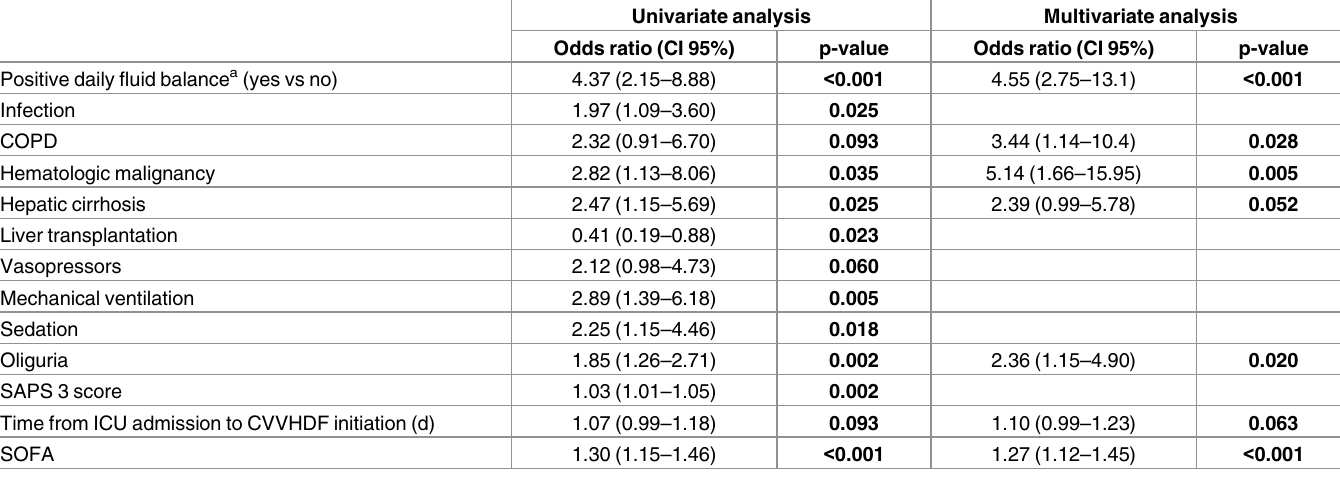
Table 3. Multivariate logistic regression with death at 90 days.